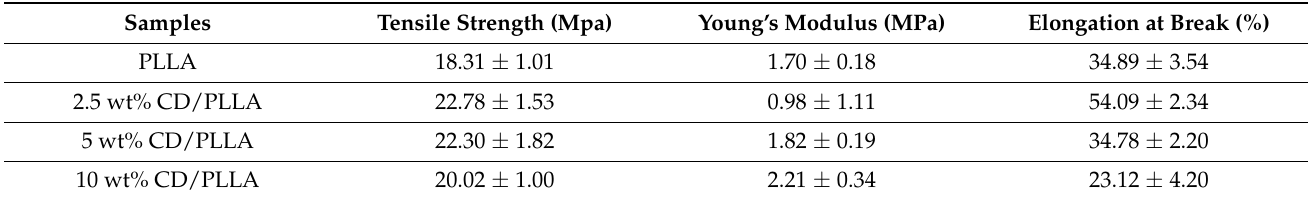
Table 3. Summary of tensile strength, Young’s modulus, and elongation at break of PLLA and CD/PLLA nanofibers.